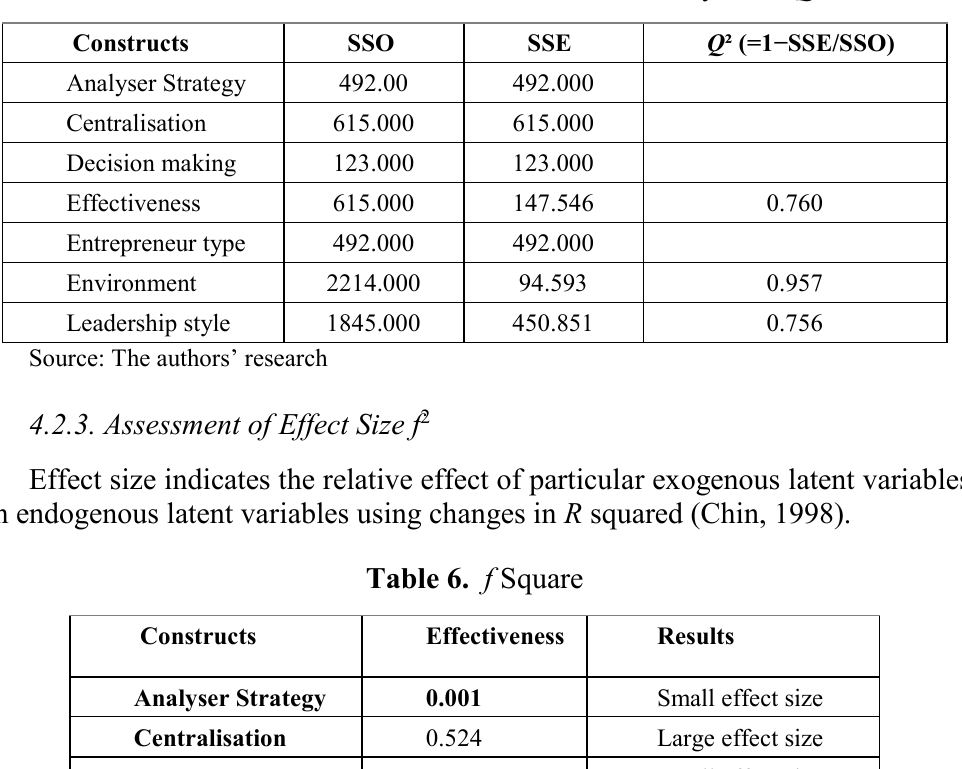
Table 5. Construct Cross-Validated Redundancy Total Q 2